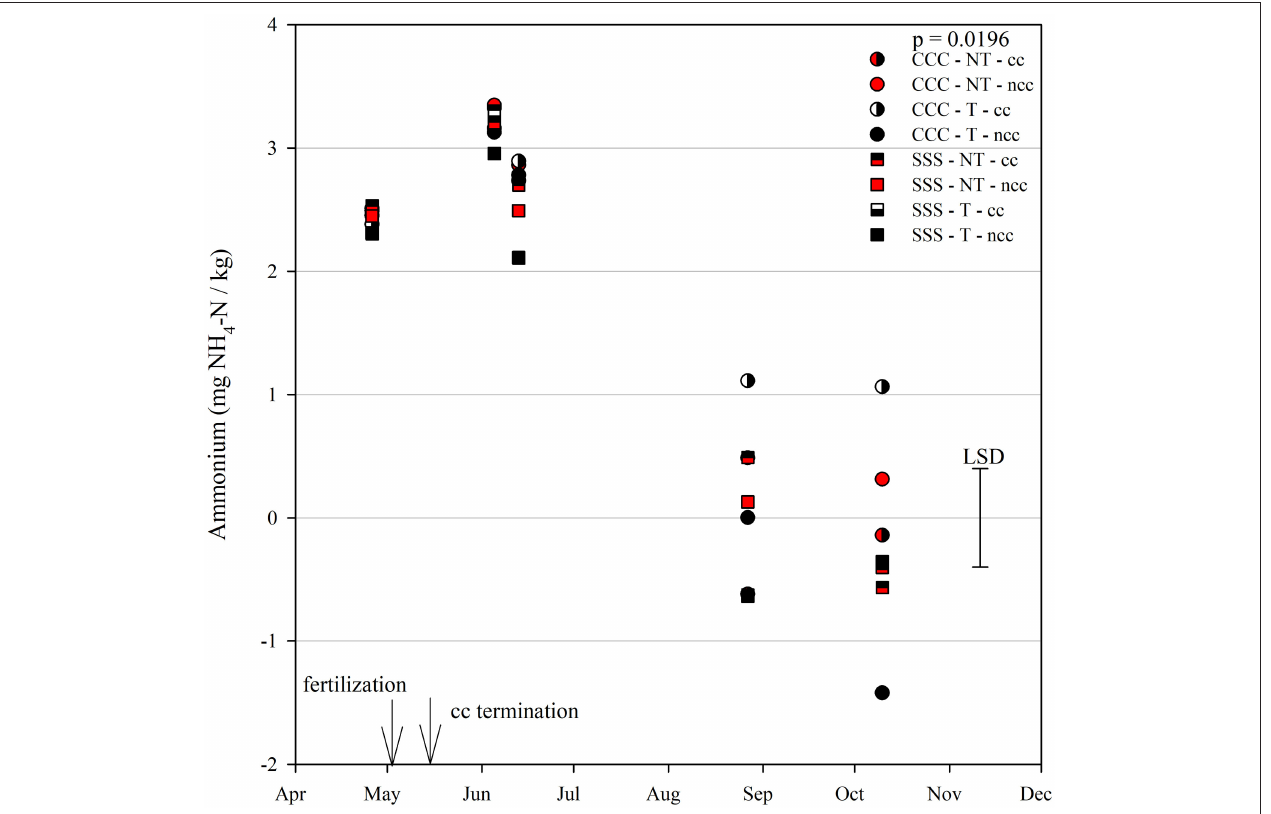
FIGURE 3 | Mean lognormal transformed soil ammonium values (mg NH 4 -N kg − 1 ) throughout the 2019 growing season separated by crop rotation [CCC, continuous corn (circles); SSS, continuous soybean (squares)], tillage [NT, no-till (red); T, chisel tillage (black)], and cover crop [CC, cover crop (partial fill); NCC, no cover crop (solid fill)]. Significant differences in treatment means can be interpreted by the Least Square Differences (LSD) error bar to the right of the figure. Mean values that fall beyond the distance of the LSD are significant at α =